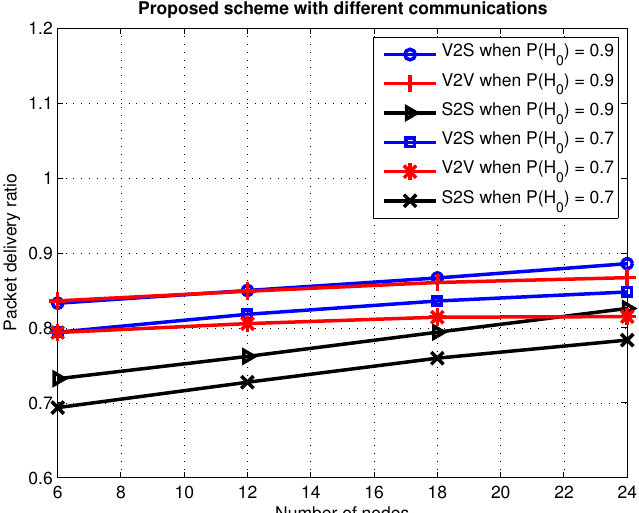
Figure 4. Performance comparison between the proposed hybrid and pure communications in terms of packet delivery